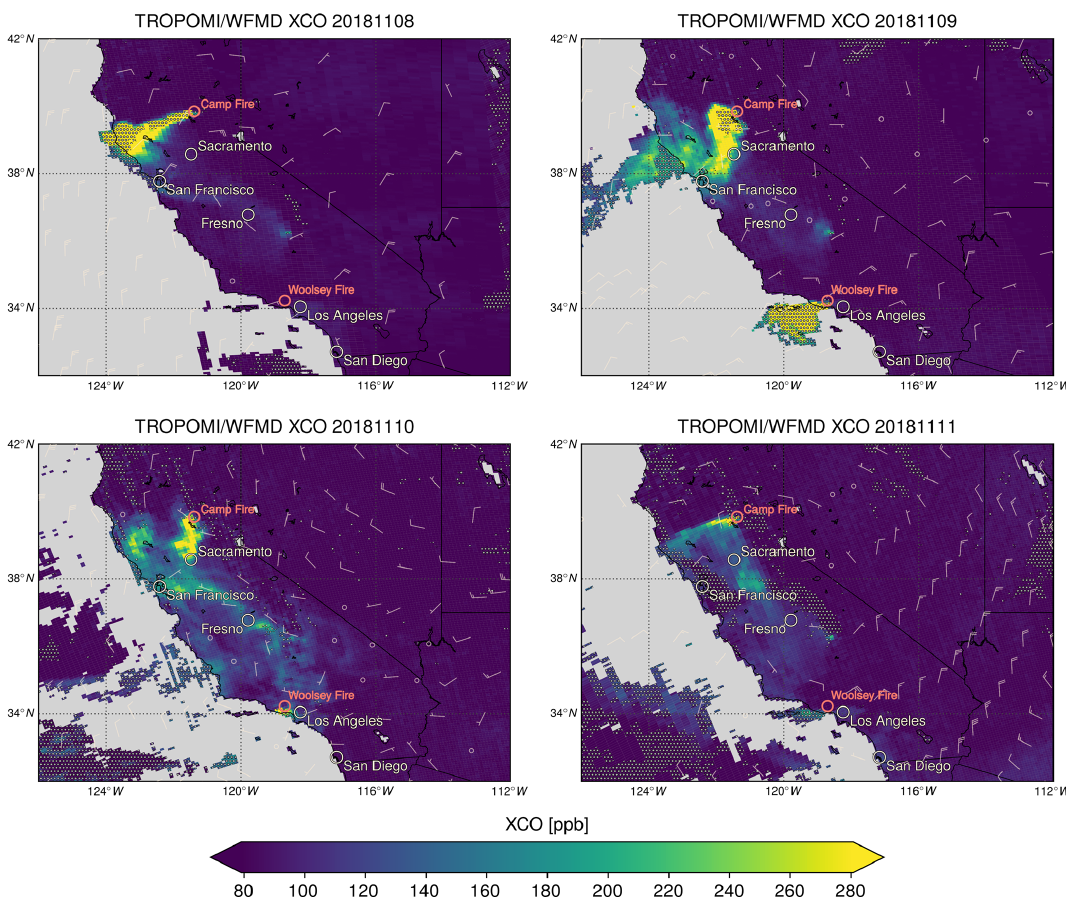
Figure 4. Retrieved carbon monoxide column-averaged mole fractions from TROPOMI for the same days as in Fig. 1. Dotted scenes are excluded by the quality filter based on simultaneously retrieved XCH 4 . Also shown is the mean wind in the boundary layer obtained from ECMWF